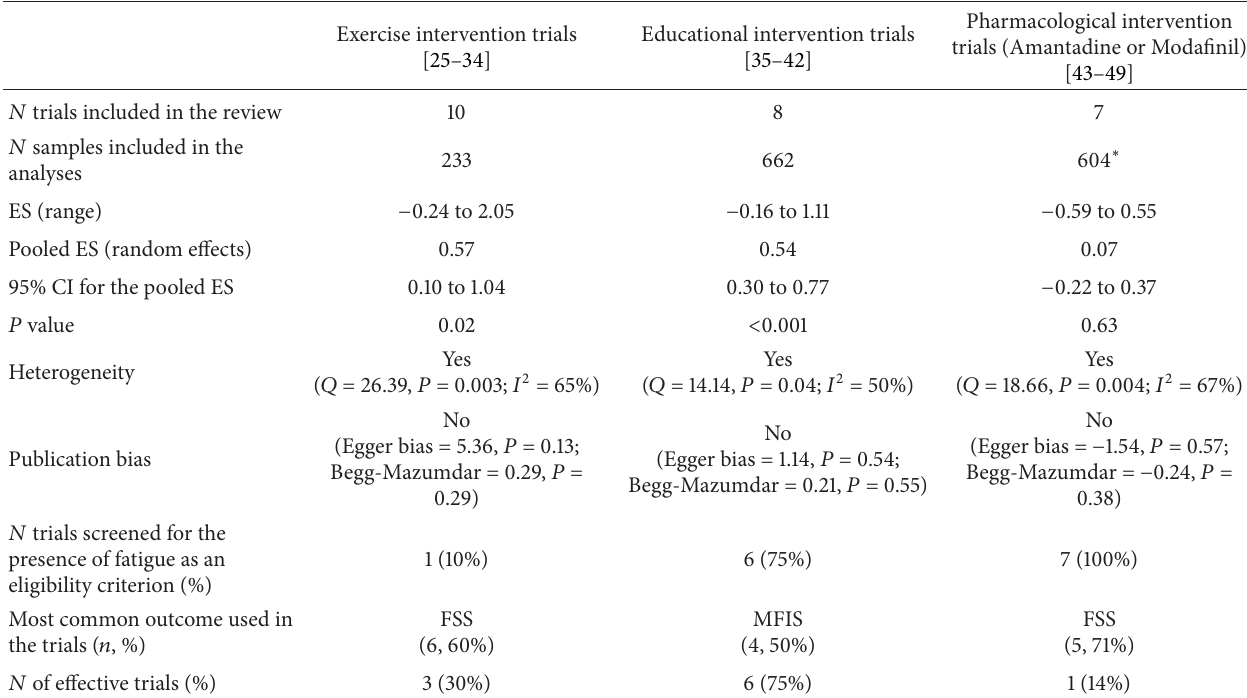
Table 1: A summary of three types of intervention